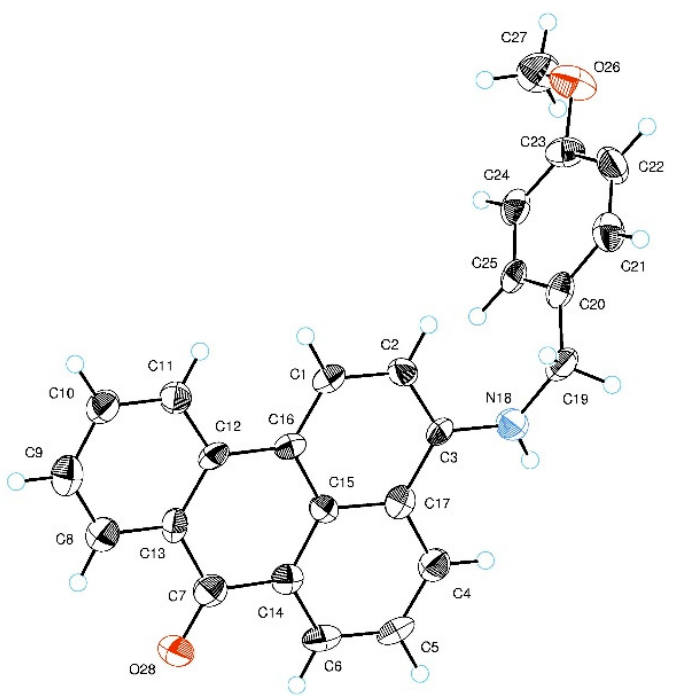
Figure 1. ORTEP diagram of molecule 3 .